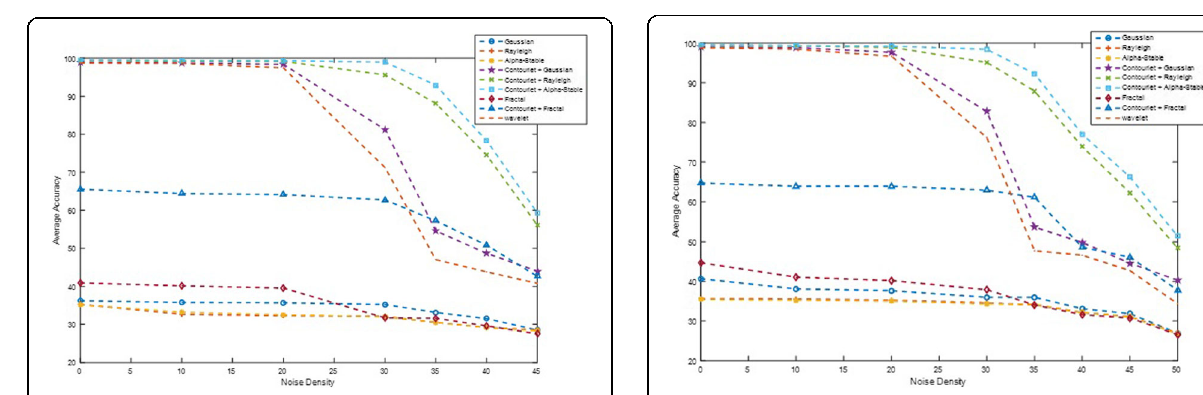
Fig. 22 Average segmentation accuracy of different methods in the presence of noise for Brodatz mosaics